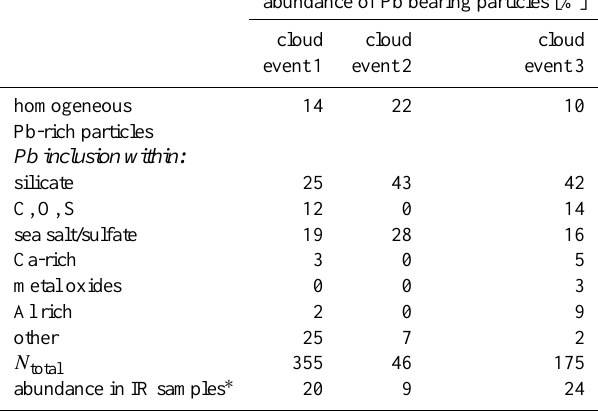
Table 5. Relative abundance of homogeneous Pb-rich particles and particles with Pb-inclusions within the group ,,Pb-bearing particles” in IR